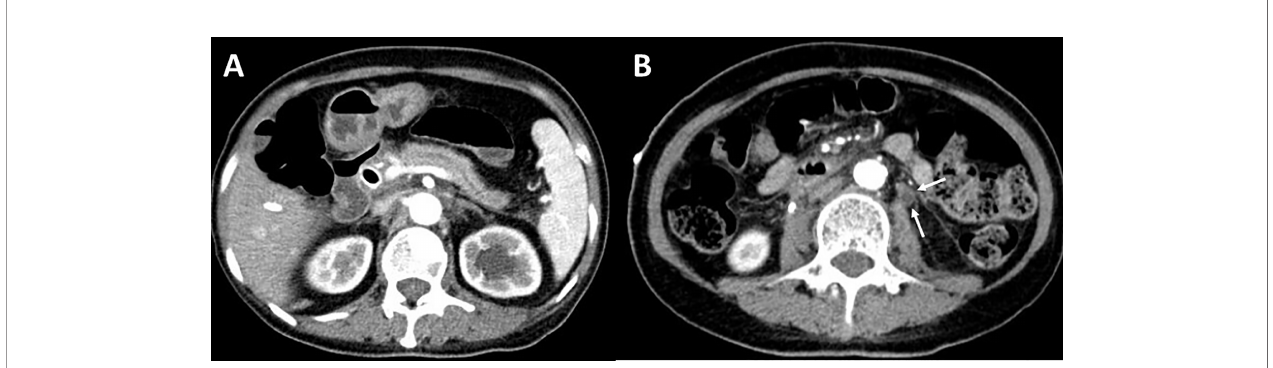
FIGURE 4 | Contrast-enhanced abdominal CT after treatment. (A) Contrast-enhanced CT reveals less in fl ammatory reactions of the pancreas. (B) Thickness of peritoneum maintained without further thickening and left ureterectasia partly relieved (white